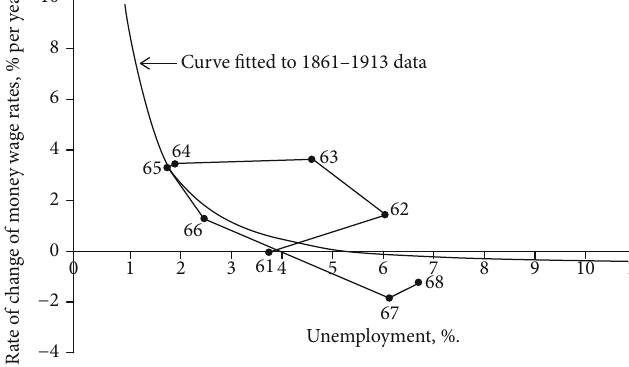
Figure 7: Phillips ’ famous “ loops.